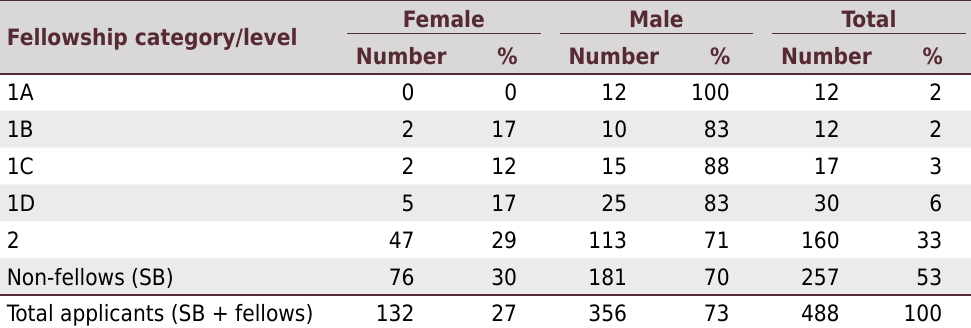
Table 1. Number and percentage of fellowship holders who requested renewal or new fellowship in CNPq Call 2018, classified by gender and class of fellowship PQ Fellowship